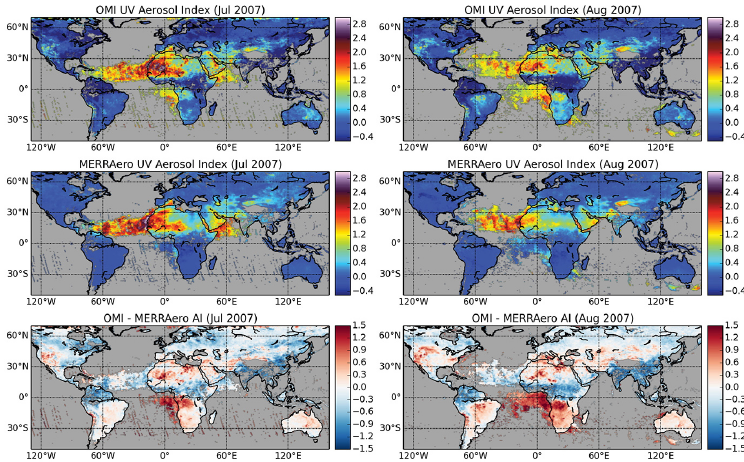
Figure 2. Monthly mean of OMI UV AI (top) and MERRAero-simulated AI (middle) for July (left) and August (right) 2007. Difference of AI OMI minus MERRAero (bottom plots).